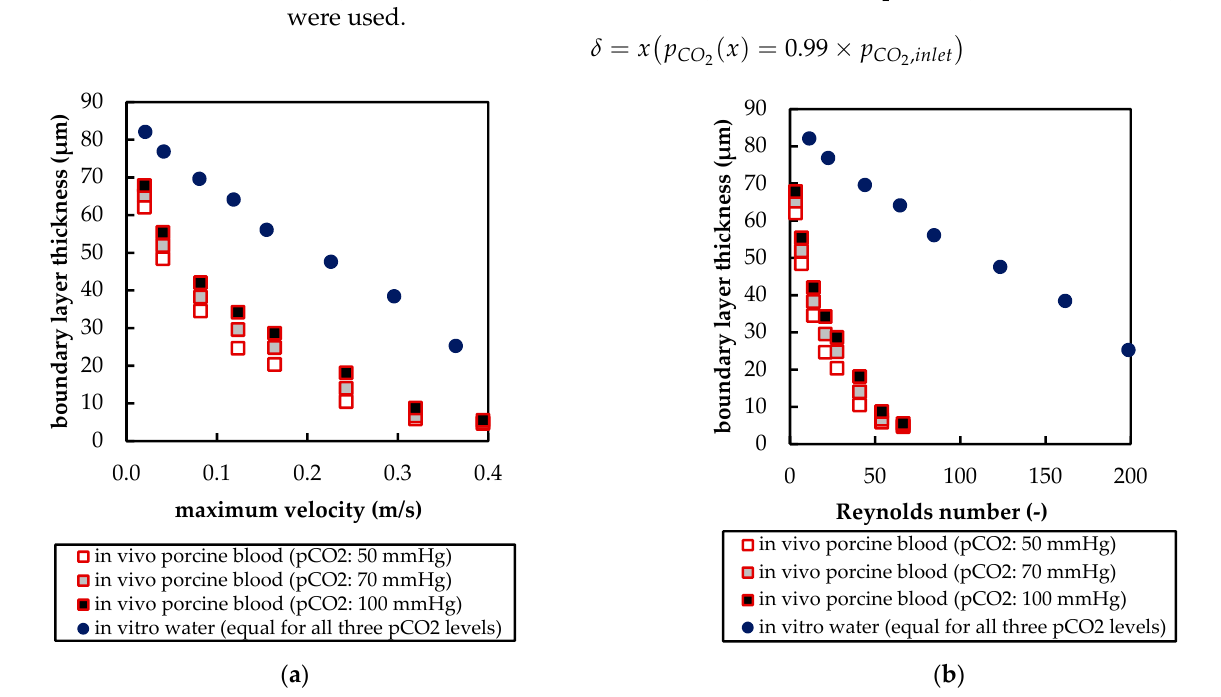
Figure 17. Dependency of boundary layer thickness on: ( a ) maximum velocity between fibers; ( b ) Reynolds number computed with maximum velocity between fibers.